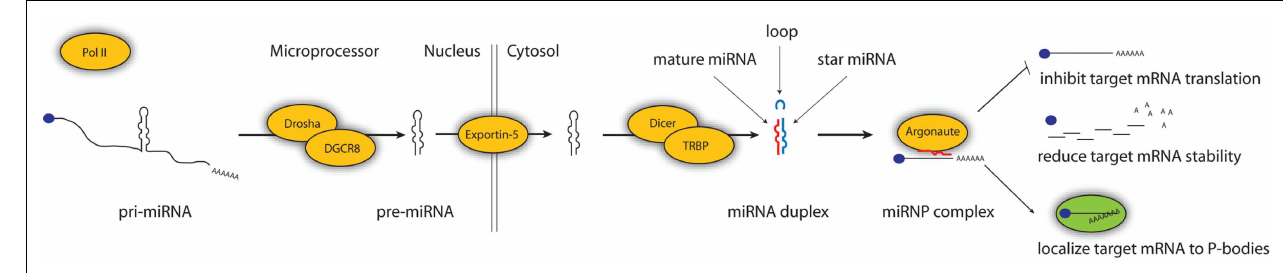
“passenger” strand) and the terminal loop.The guide strand is then bound by an Argonaute protein, which is part of the miRNP effector complex. Once thus bound, the miRNA can bind to target sites, often located in the 3 (cid:48) UTR of protein coding transcripts, and guide the effector complex to inhibit translation of the target, cause its degradation, or relocate it to subcellular foci, where they are no longer accessible to the translation